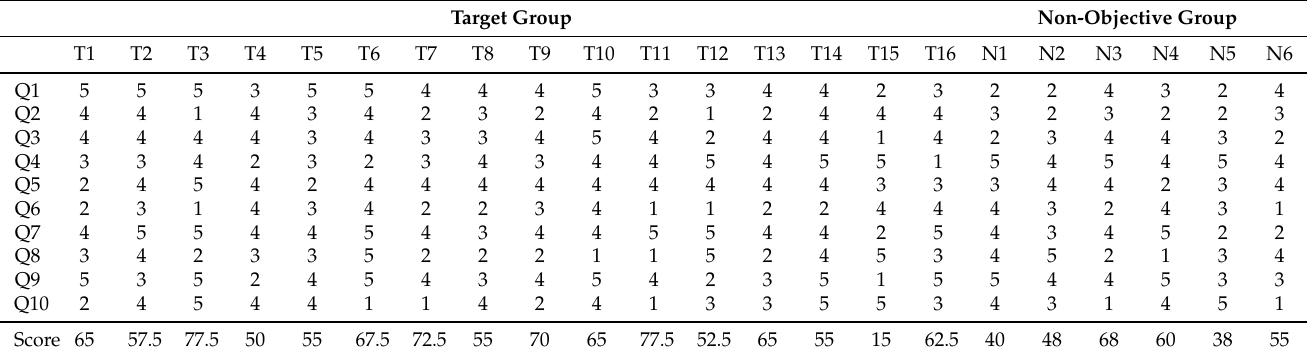
Table 1. SUS individual items’ response: target and non-objective groups.